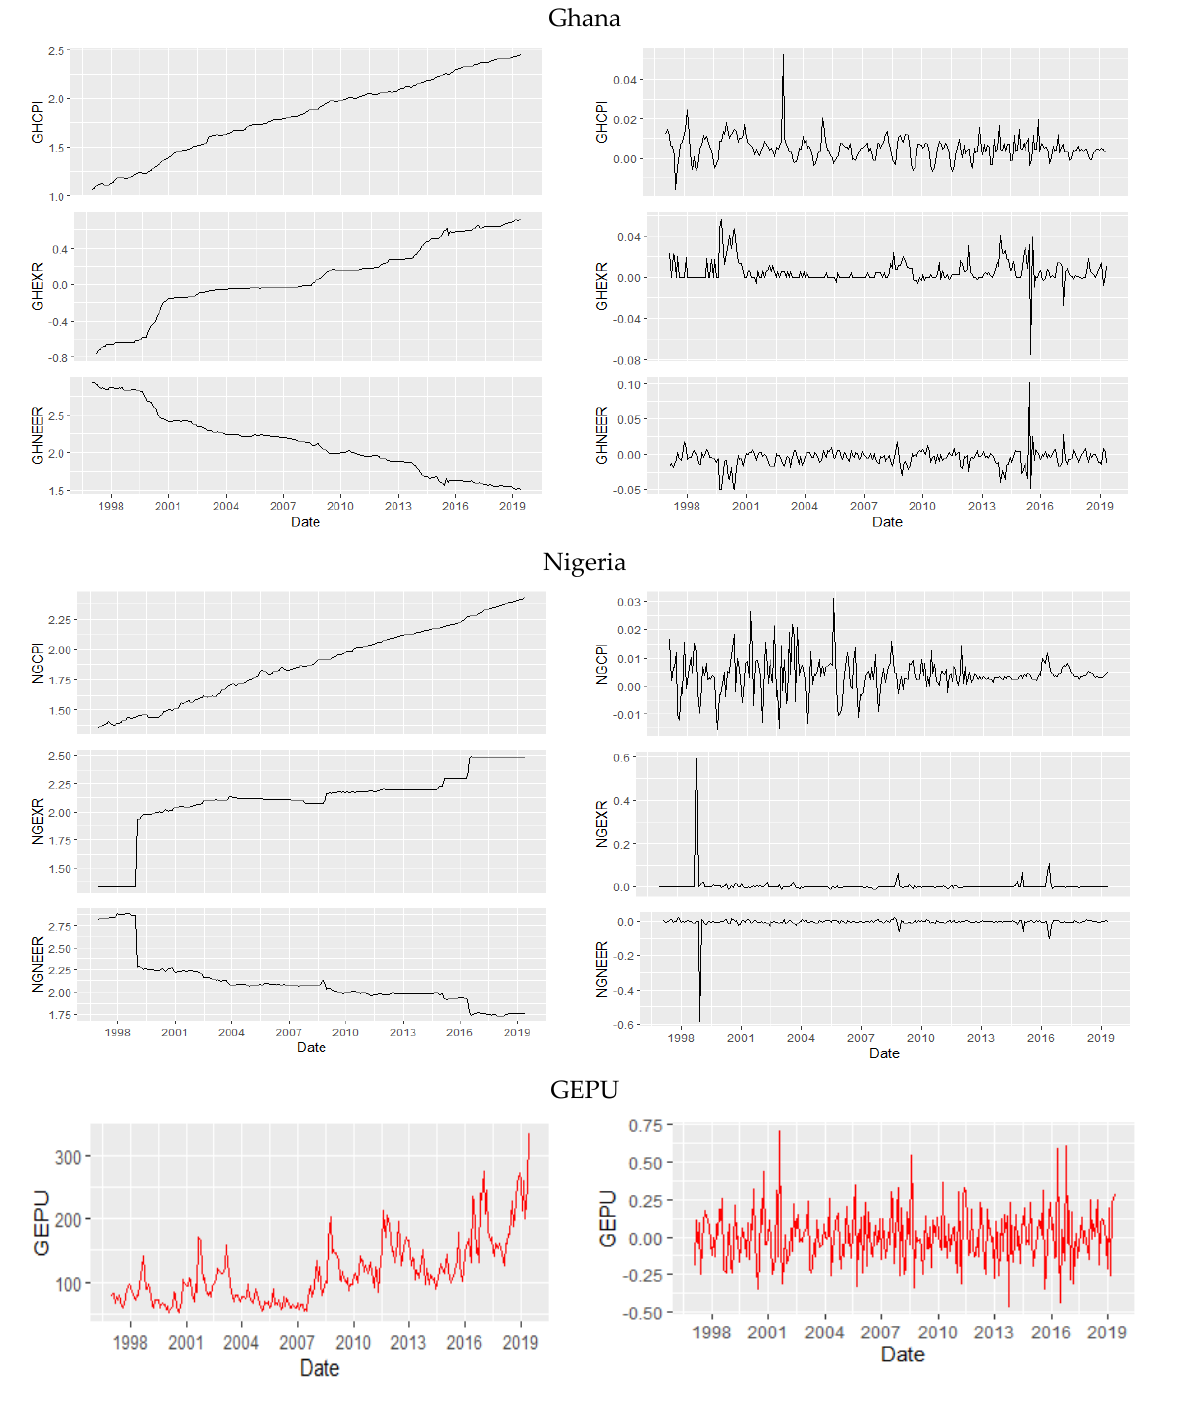
Figure 1. Plots of prices and return series of macroeconomic